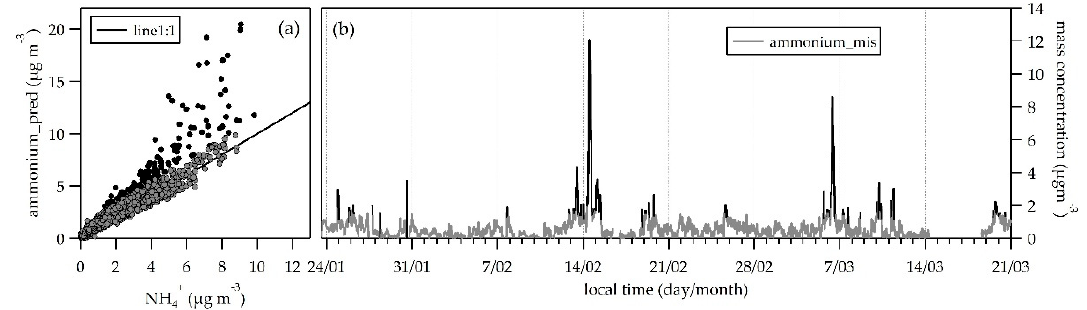
Figure 5. ( a ) Scatter plot of the predicted ammonium assuming neutrality (ammonium_pred) vs. the measured ammonium. ( b ) Time series of the extra ammonium needed to neutralize the aerosol (ammonium_mis). Data points with ammonium_mis larger than the average plus one standard deviation are colored in black for visualization purposes.